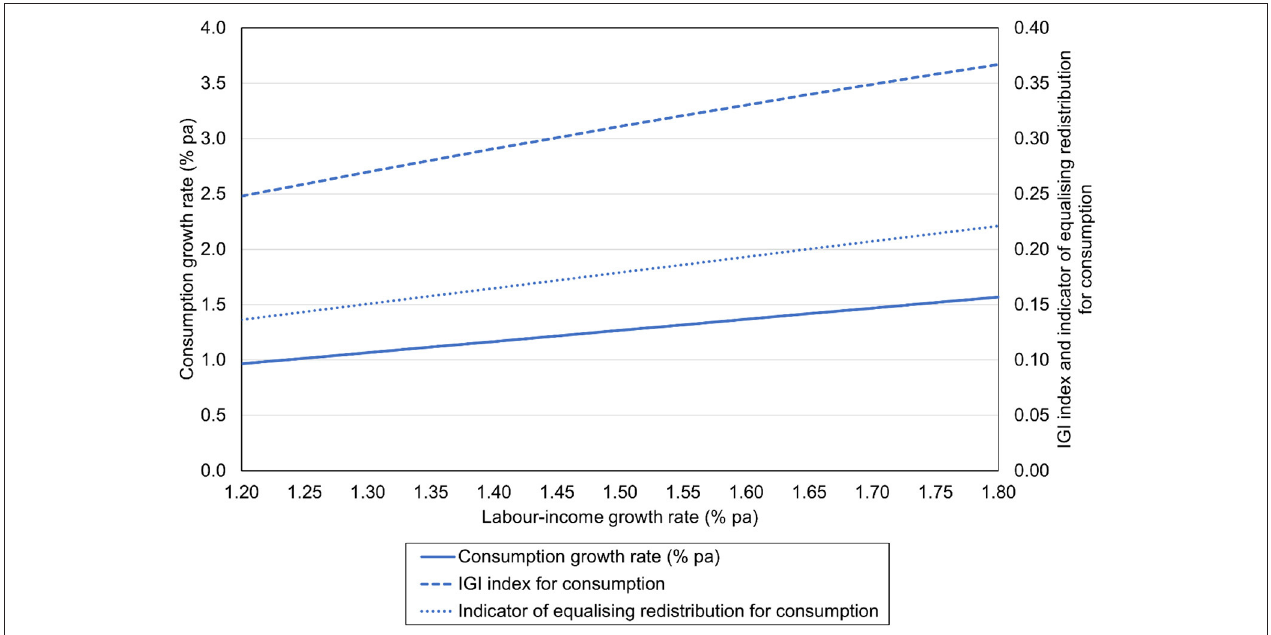
FIGURE 2 | Age-specific, per capita consumption growth rates, the IGI index for consumption, and the indicator of equalizing redistribution for consumption by age-specific, per capita labor-income growth rates, 2020–2120, Australia. This figure assumes that the Medium demographic scenario